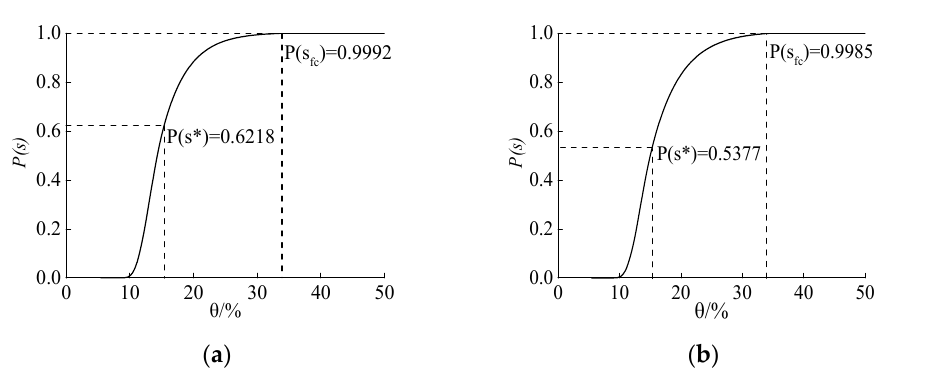
Figure 10. PDF of soil moisture at different sampling intervals. ( a ) Calibration period; ( b ) Validation period.